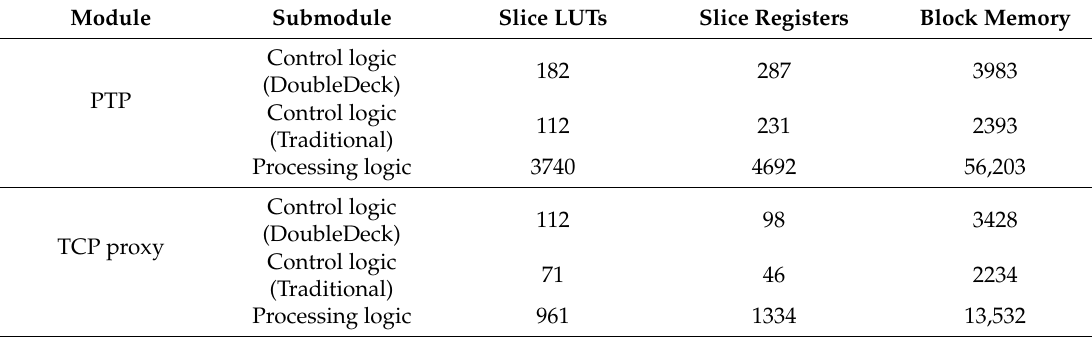
Table 4. The resource consumption of key modules in PTP and TCP